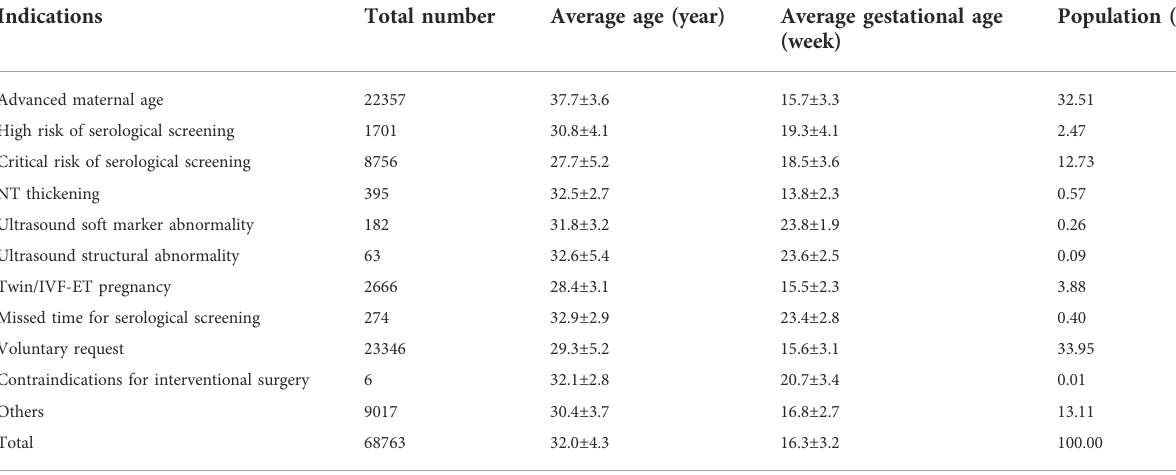
TABLE 1 Basic information and proportion of different screening indications for NIPT.